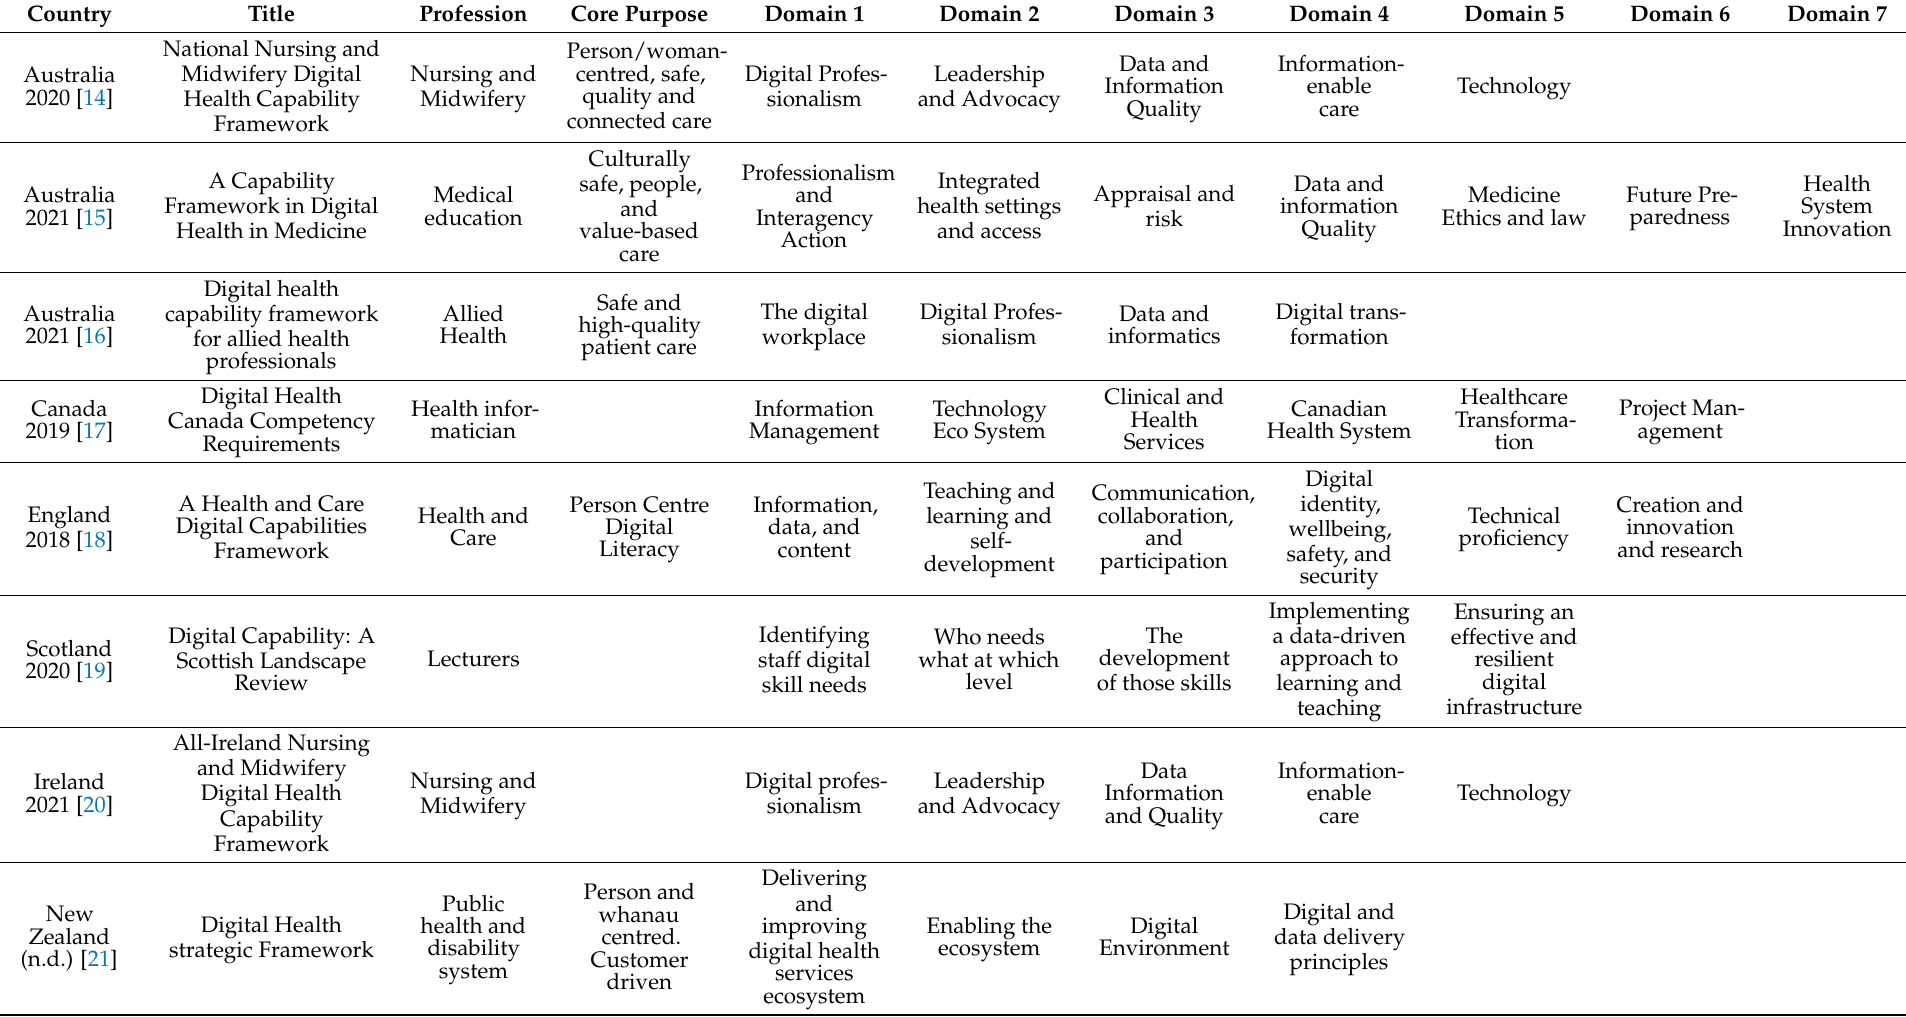
Table 1. The key domains of current digital capability